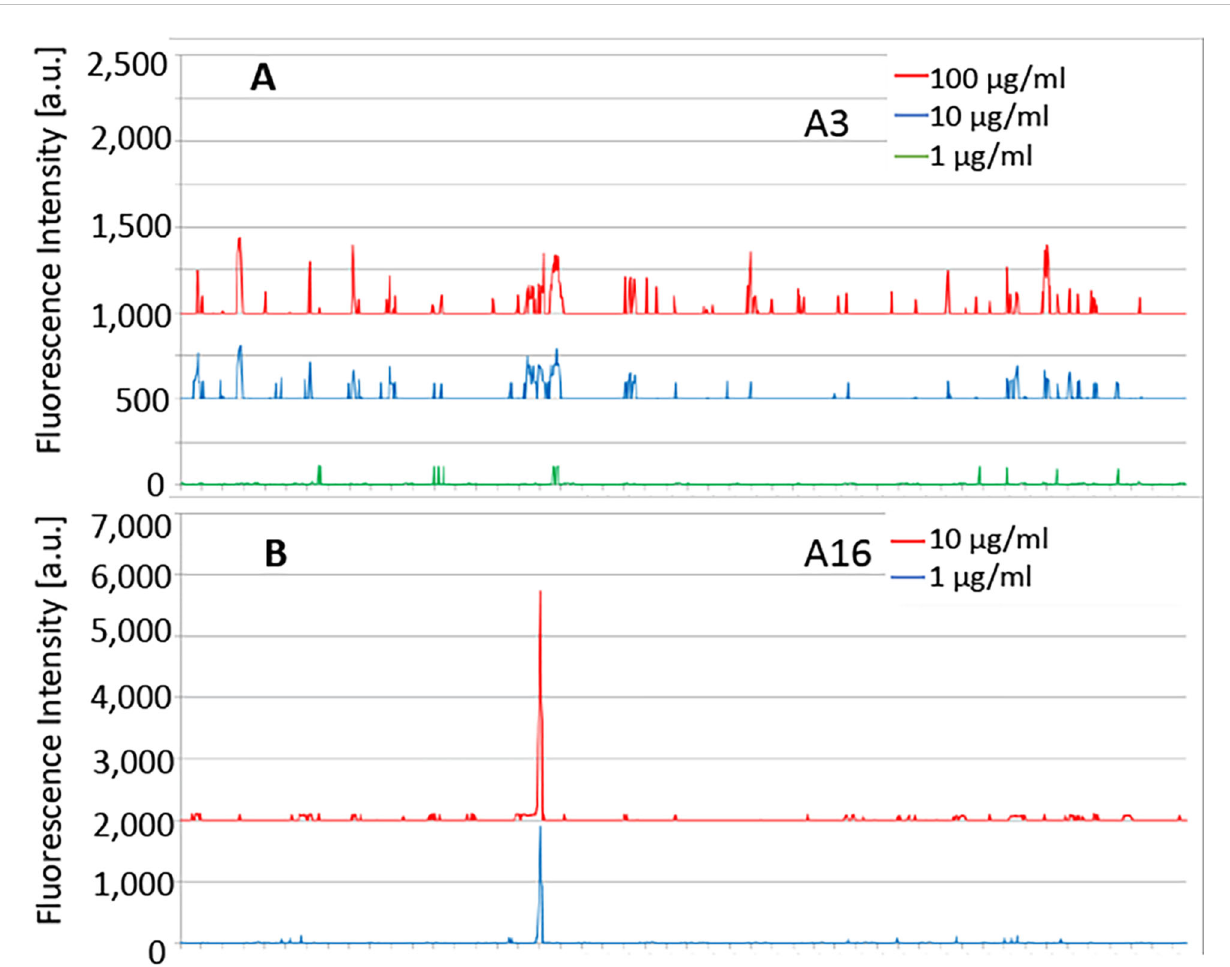
FIGURE 6 The customized peptide arrays map epitopes of A3 and A16. (A) No speci fi c linear epitopes were detected for A3. (B) The epitope of A16 was detected. Strong monoclonal antibody response against a single epitope-like spot pattern formed by adjacent peptides with the consensus motif REDLAALEKD on a